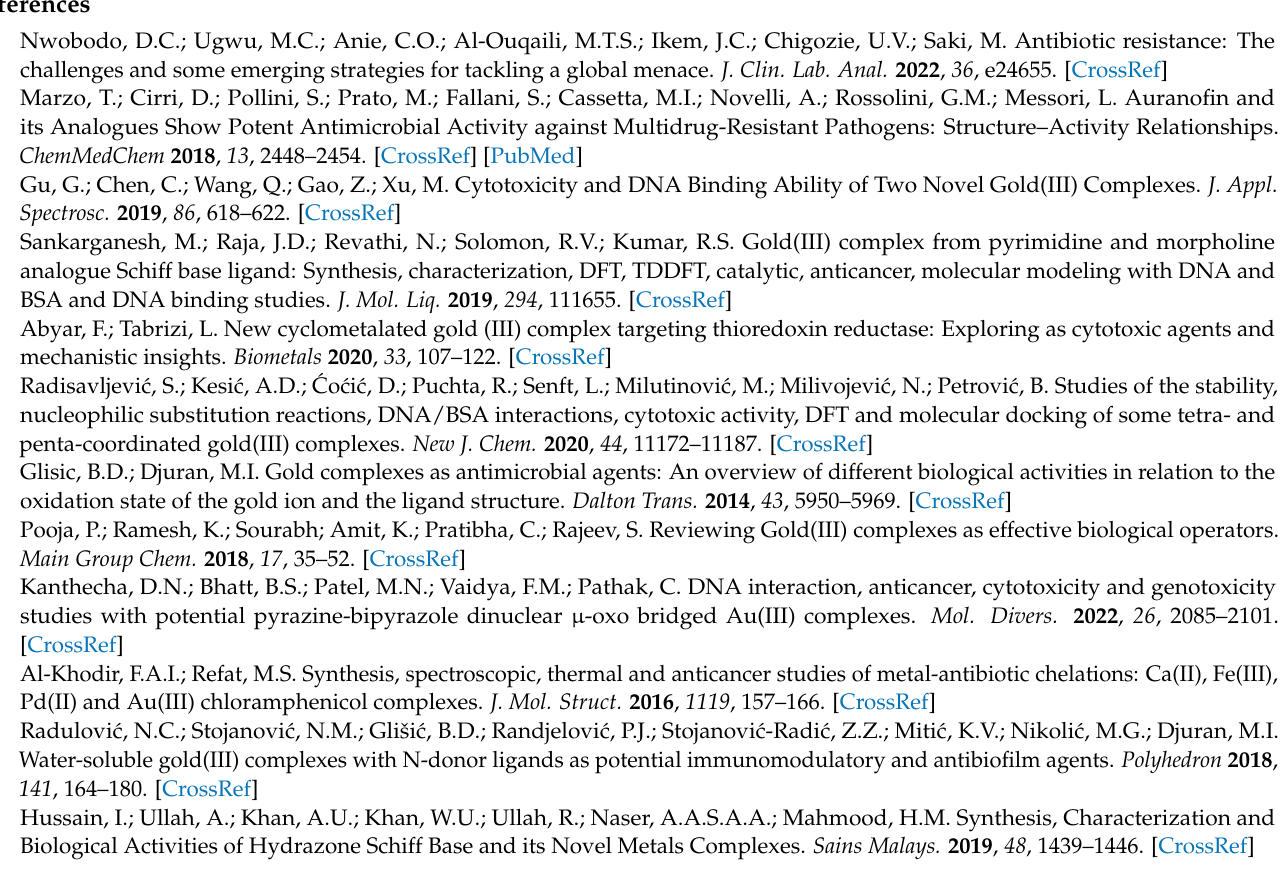
10 µ L volume. Figure S4: Calculated UV–Vis spectra of individual protonated and complex species of PLP-T2H (a), PLP-F3H (b), PLP-T3H . Spectra of protonated species are adopted from